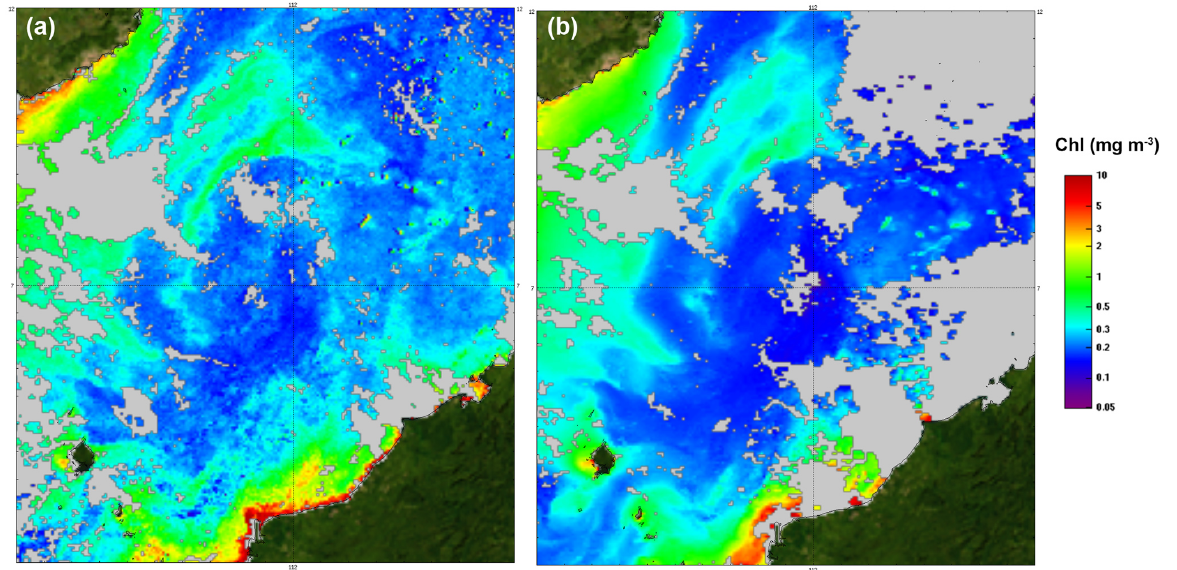
Figure 11. The chlorophyll a concentration (1 January 2012) for (a) the OC-CCI level 3 product and (b) the GlobColour product.